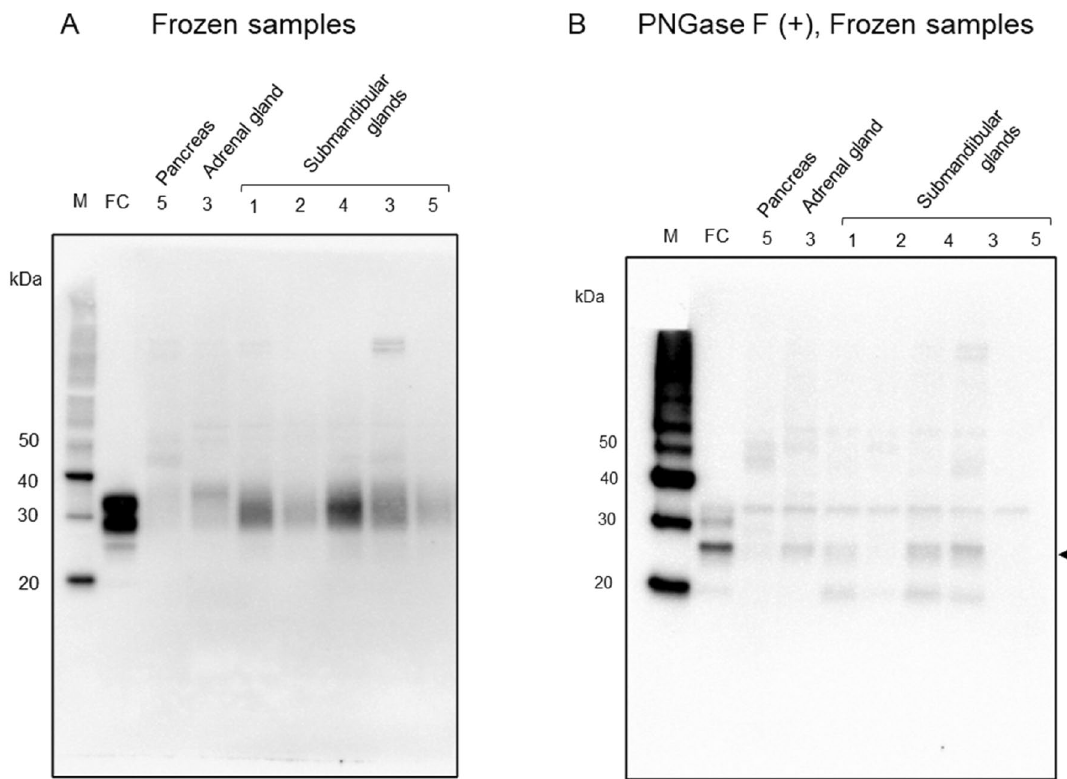
Figure 4. Western blot analyses from frozen samples ( A ) and western blot analysis after deglycosylated treatment ( B ). ( A ) In the frontal cortex (FC), PrP signals, nonglycosylated, strong mono and deglycosylated bands are observed at the molecular weight of 25–38 kDa. In the pancreas (case 5), adrenal gland (case 3) and submandibular glands (case 1–5), ~ 30–40 kDa PrP smear signals were noted. ( B ) After deglycosylated treatment with PNGaseF, 25 kDa PrP signals were most prominent in the frontal cortex, adrenal gland (case 3) and submandibular glands (case 1, 3 and